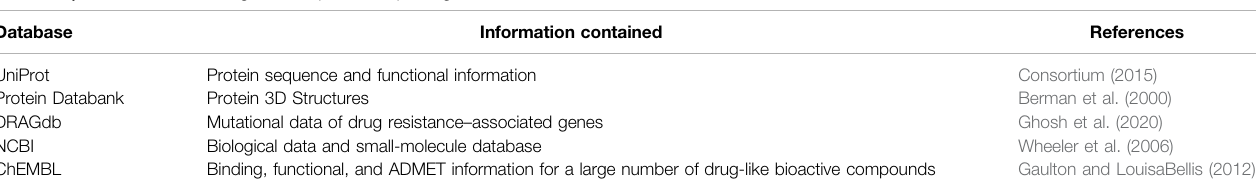
TABLE 3 | Databases used alongside computational